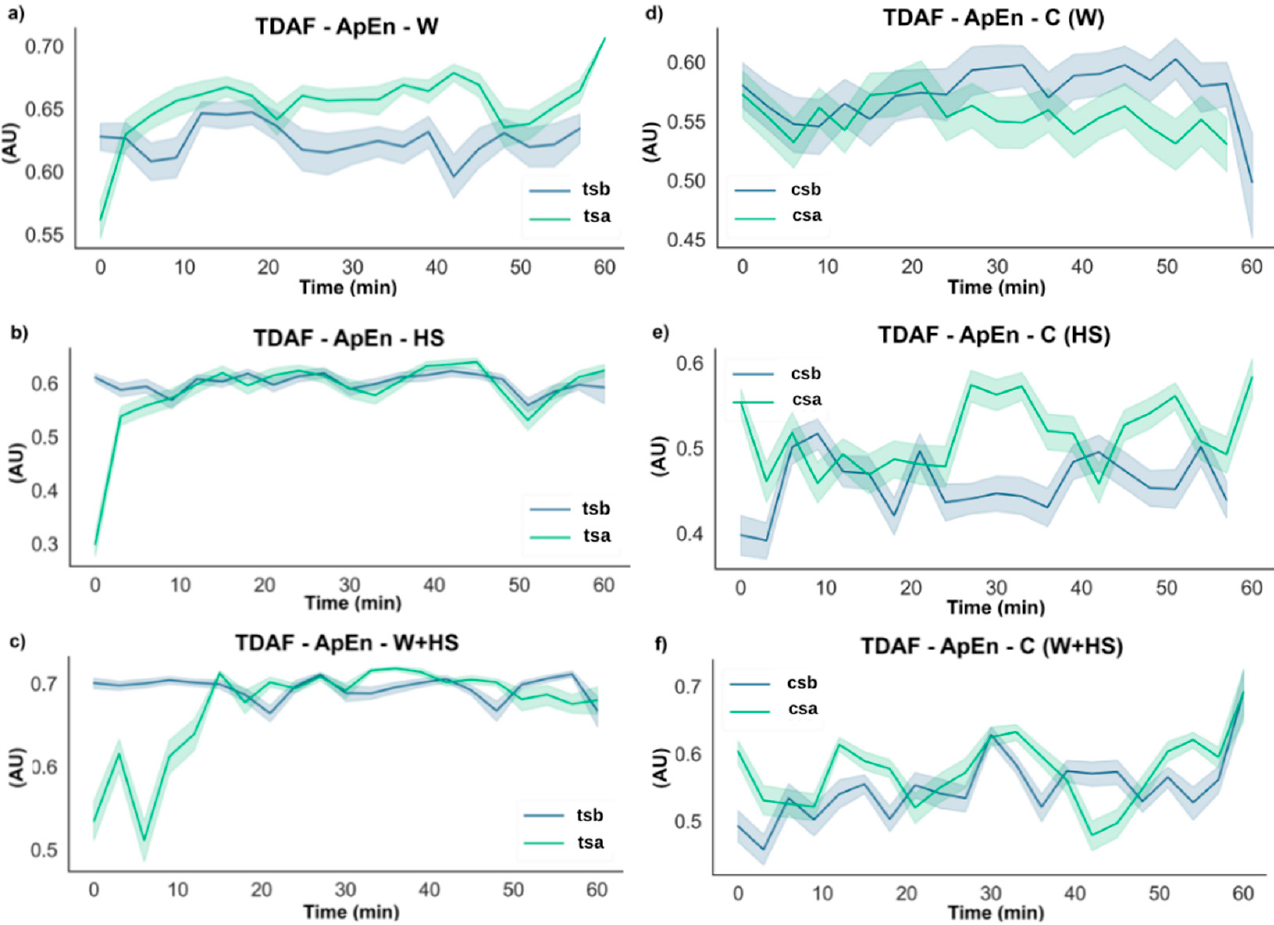
Figure 4. TDAF plots for ApEn analysis. Results for ( a ) systemic wounding (W), ( b ) heat shock (HS), and ( c ) wounding + heat shock (W+HS). Results of the control plants for ( d – f ) wounding C (W), heat shock C (HS), and wounding + heat shock C (W+HS), respectively. tsb: treated systemic before stimulus; tsa: treated systemic after stimulus; csb: control systemic before stimulus; csa: control systemic after stimulus. AU: arbitrary unit.